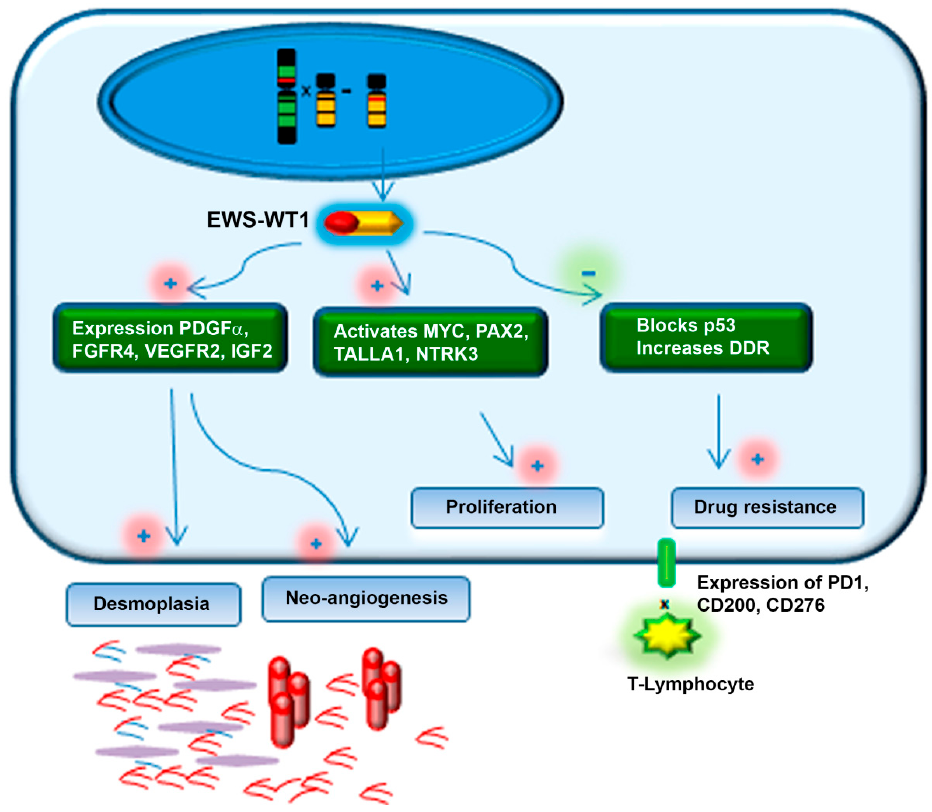
Figure 2. Schematic representation of EWS–WT1 fusion protein mechanism of action in desmoplastic small round cell tumor. Increase in tyrosine-kinase receptor expression, modulation of DNA replication proteins, activation of DNA-Damage Repair (DRR) machinery resulting in proliferation, desmoplasia, neo-angiogenesis and drug resistance.